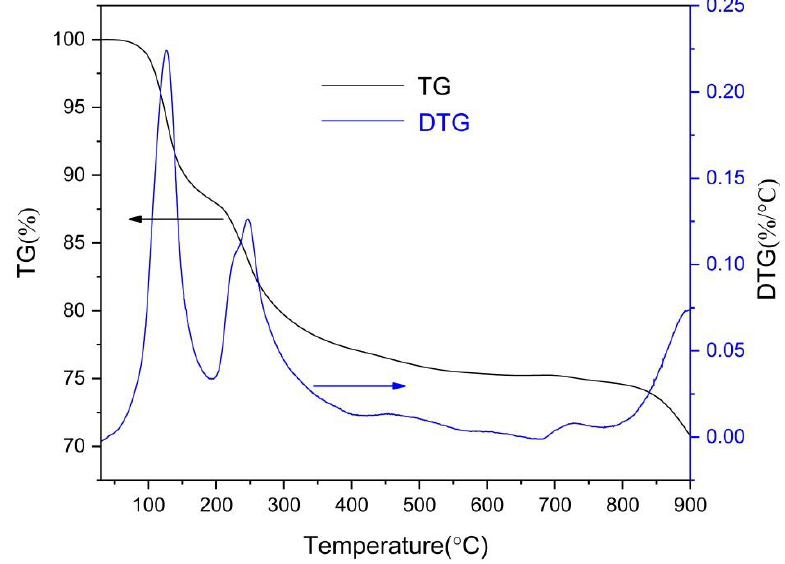
Figure 2. Thermogravimetric analysis (TGA) curves of HA-0.5MCu macrobeads.